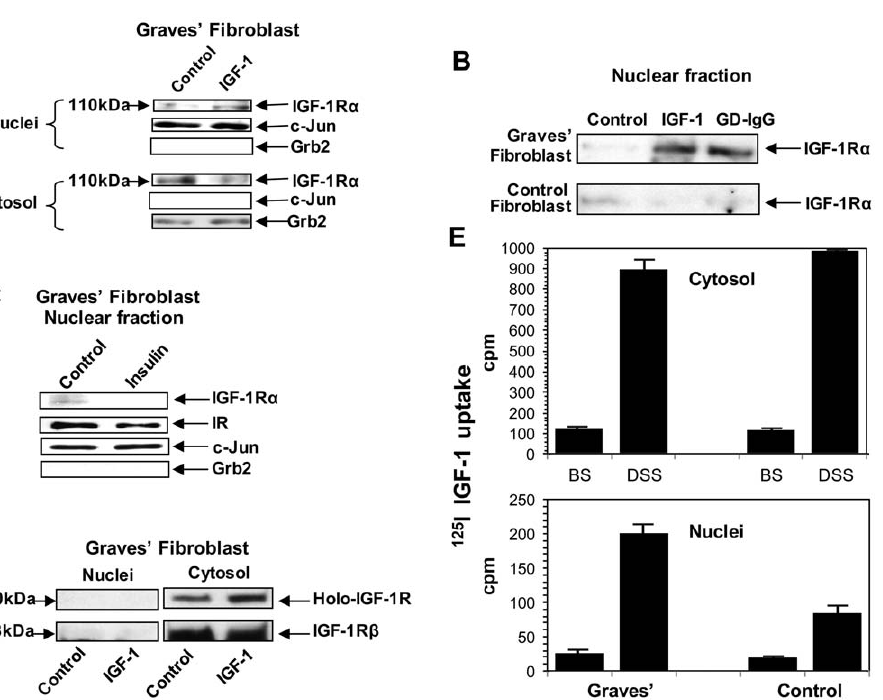
Figure 2. IGF-1R protein differentially accumulates in the nuclei of TAO orbital fibroblasts and derives from the fibroblast surface. ( A ) Western blot analysis of nuclear and cytoplasmic IGF-1R a in GD orbital fibroblasts before and following IGF-1 (10 nM) treatment for 16 h. Cells were subjected to subcellular fractionation as described in ‘‘Methods’’ and membranes were probed with anti-IGF-1R a , stripped, and re-probed with anti-Grb2 (cytoplasmic) and anti-c-Jun (nuclear) Abs. ( B ) Nuclear IGF-1R a content in GD and control orbital fibroblasts before or following treatment with either IGF-1 (10 nM) or GD-IgG (15 m g/ml) for 16 hours. ( C ) Insulin fails to alter the nuclear content of IR or IGF-1R a in GD orbital fibroblasts. Cells were treated with nothing or insulin (15 m g/ml) for 16 hrs. They were subjected to subcellular fractionation and Western blot analysis. ( D ) IGF-1R b (98 kDa) and the intact receptor (200 kDa) are undetectable in the nucleus under basal and IGF-1-treated conditions. ( E ) Control and GD fibroblasts were subjected to 125 I-IGF-1 cross-linking with either the cell-impermeable agent, BS, or the cell permeable agent, DSS. They were then treated with IGF-1. Nuclei were separated as described in ‘‘Methods’’ and subjected to quantification of radioactivity. Results are representative of three experiments performed.